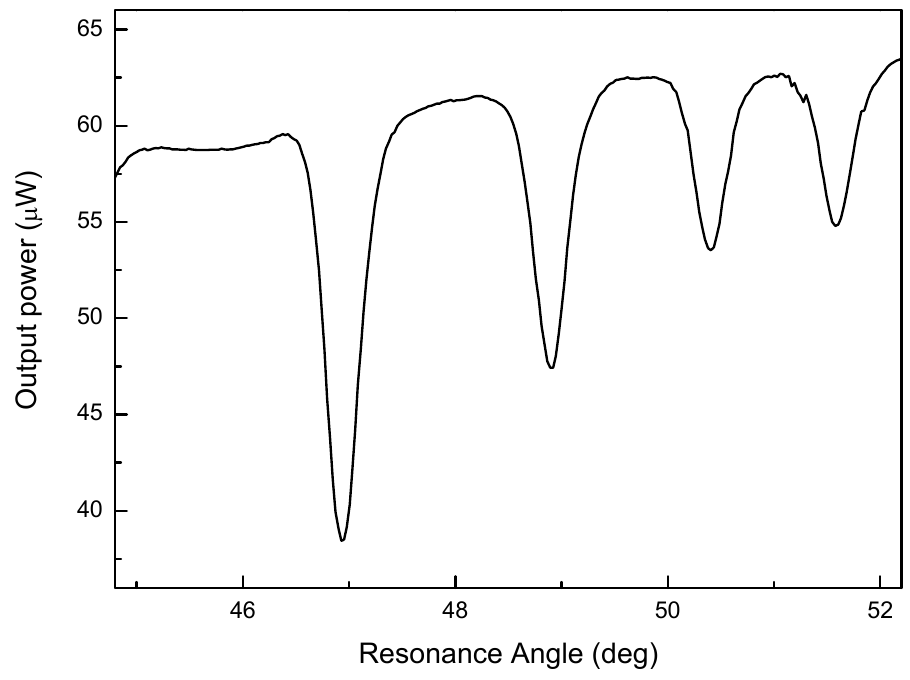
Figure 3. Resonant peaks of the waveguide, corresponding to four guided modes in TE polarization at 785 nm, after functionalization with APTES and GA.